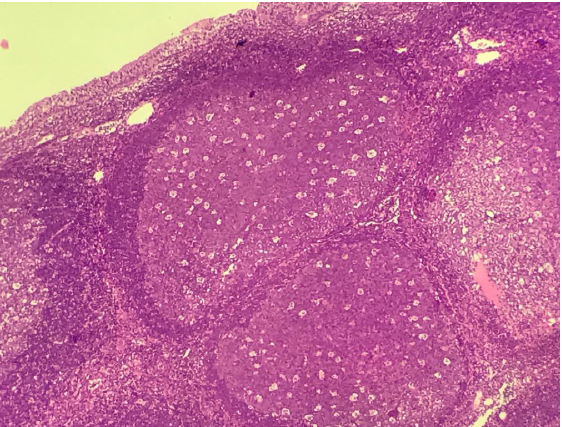
Figure 1. Bulky lymphoid follicles with activated germinal centers (hematoxicillin-eosin,